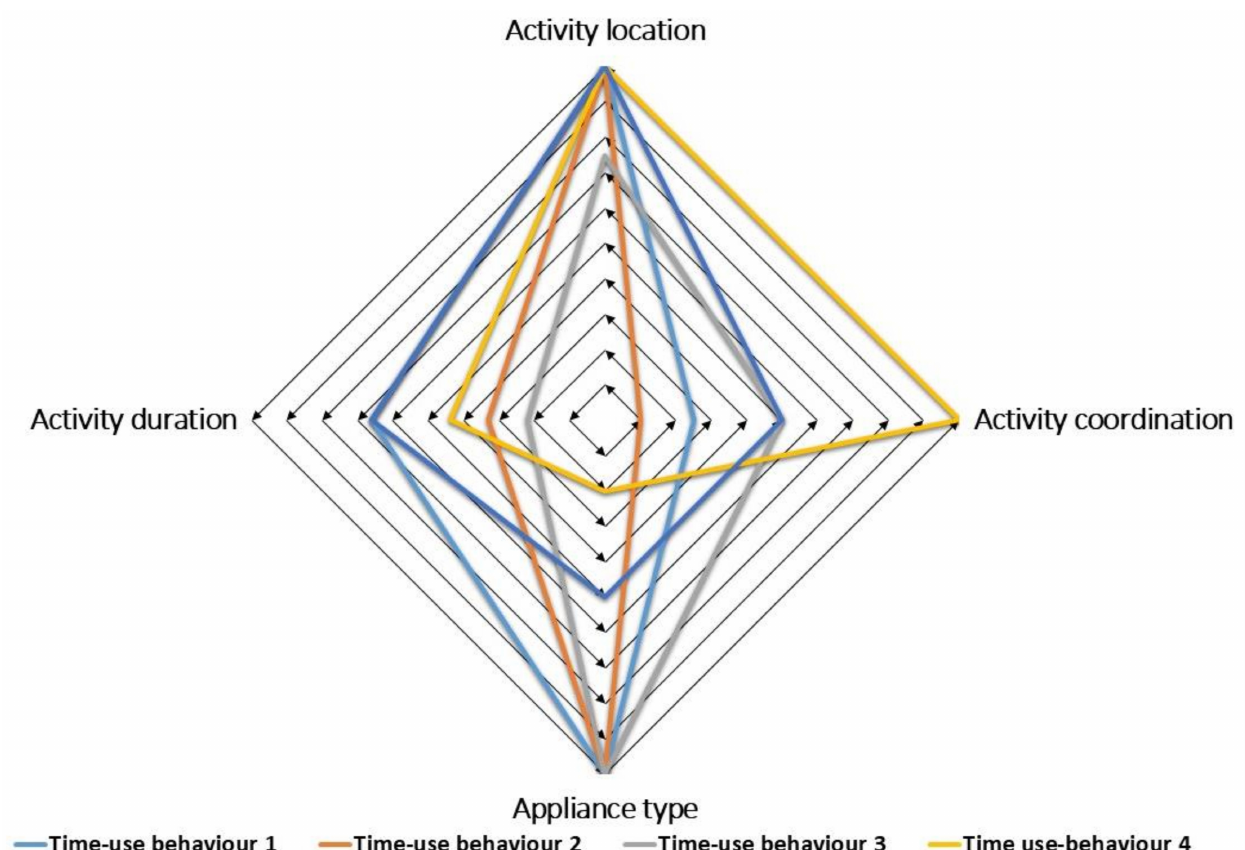
Figure 1. The four dimensions that characterise time-use behaviours. The different polygons are examples of the graphical representation of different time-use